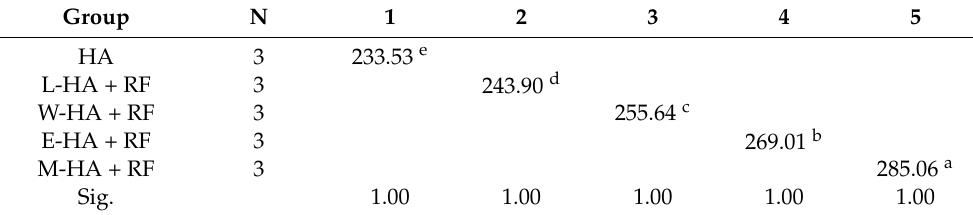
Table 2. Multiple comparison of AAC of jujube slices acquired by five drying